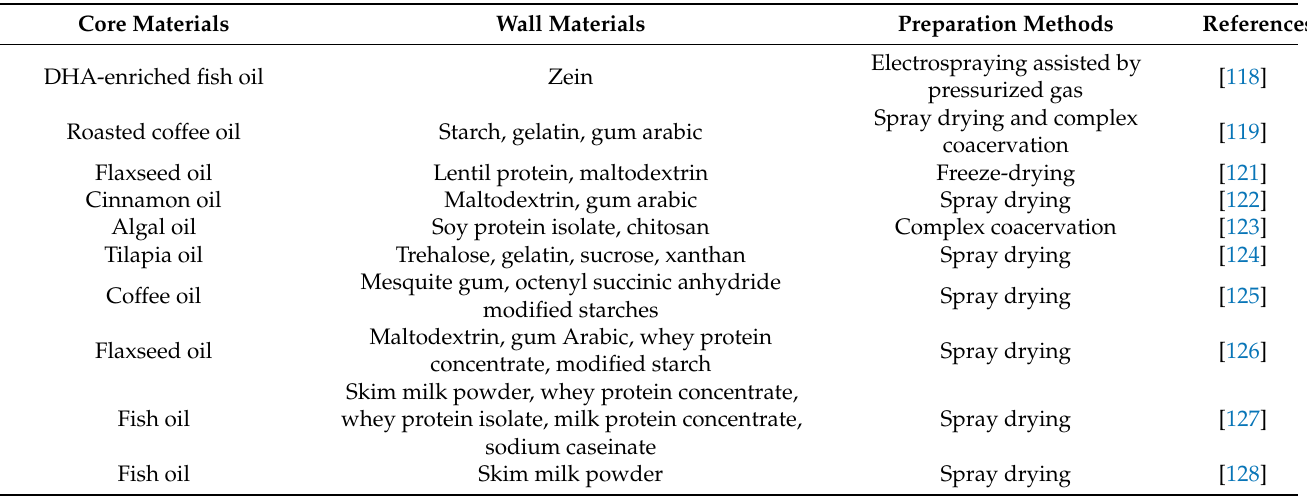
Table 7. Approaches for preparation of powdered oil